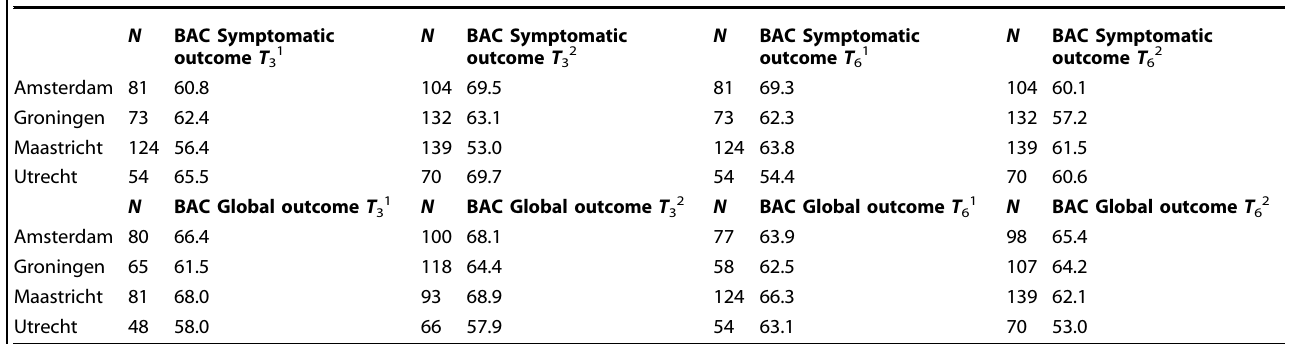
Table 4. Leave-one-site-out cross-validation site performance by